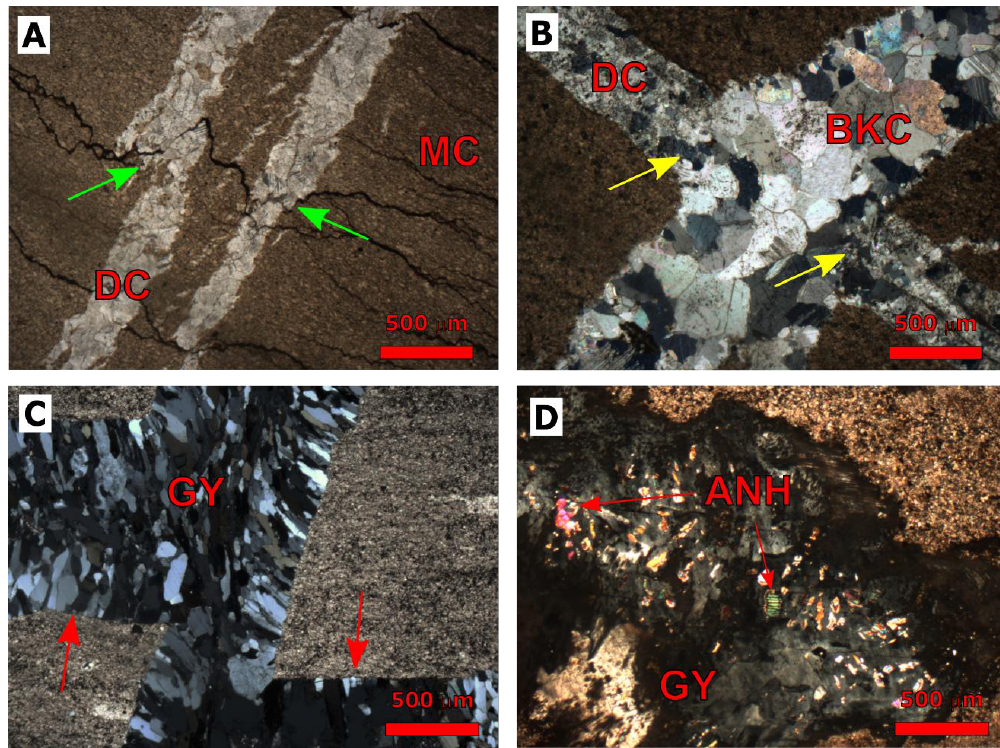
Figure 5. Fracturing in Silurian formations. ( A ) Photomicrograph (PPL) of multiple stylolites (green arrows) cross-cutting fracture-filling drusy calcite cement (DC). The surrounding matrix is micritic